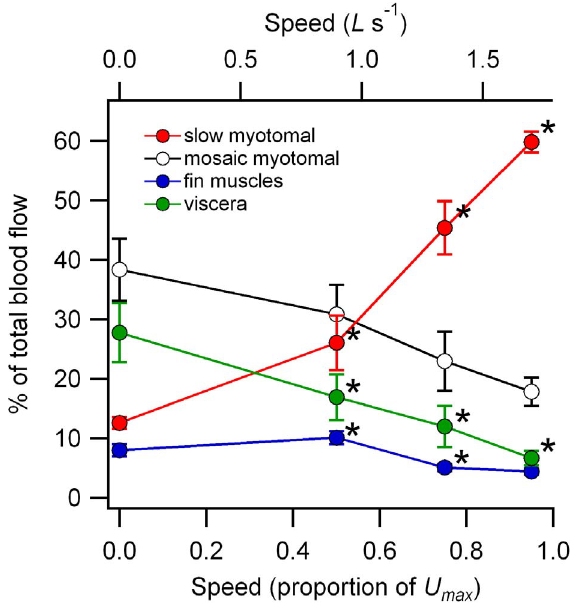
Figure 2. Percentage of total blood flow directed to the slow and mosaic myotomal musculature, fin musculature and viscera. Data are shown as mean 6 sem (N=6 to 8). * designates a significant change relative to the adjacent lower speed condition detected using a planned contrasts procedure (p , 0.05).